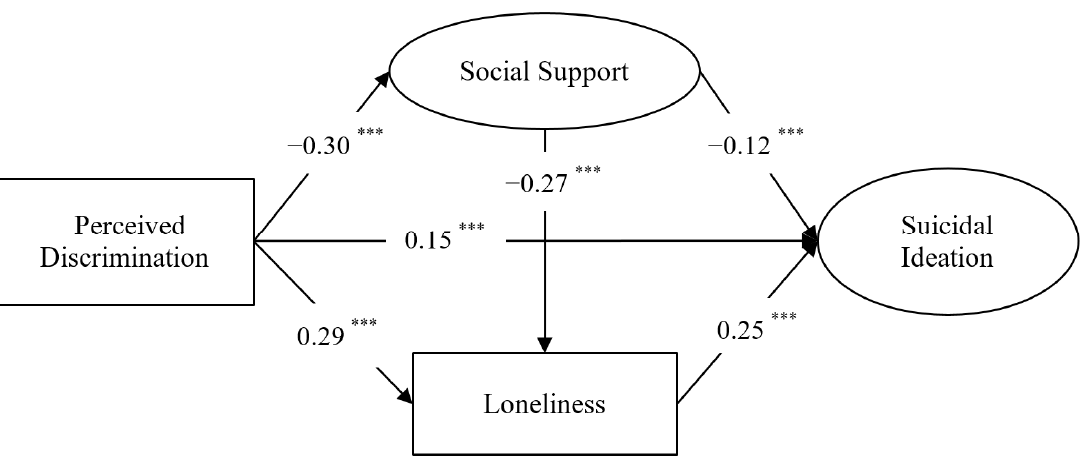
Figure 1. Multiple indirect effects model. Note: All path coefficients were standardized coefficients. *** p < 0.001.